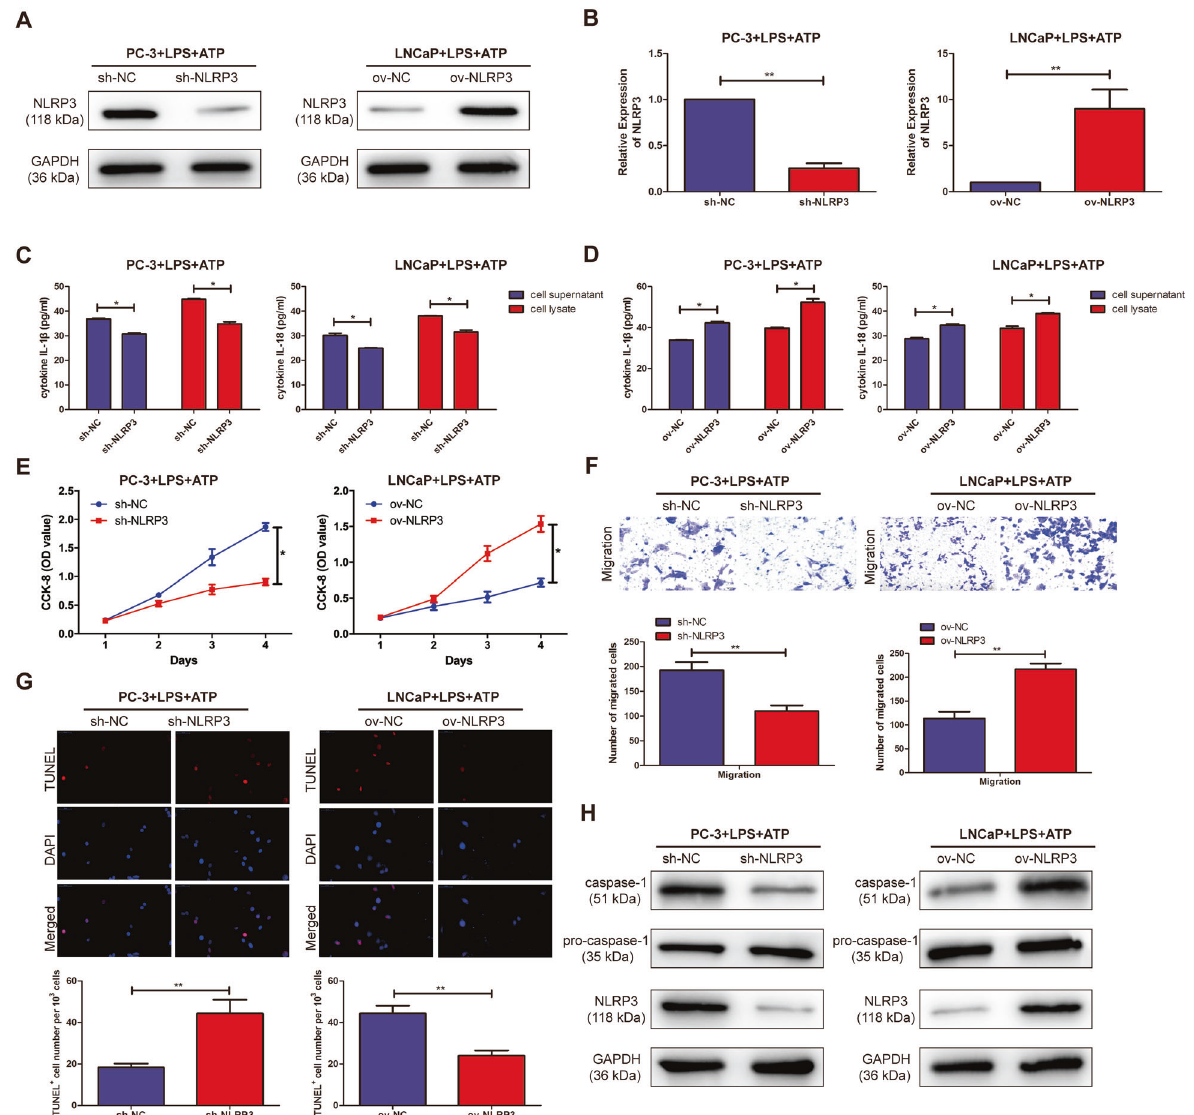
Fig. 3 Overexpression/knockdown of NLRP3 promoted/inhibited the malignant progression in PCa cell lines. A Western blotting analysis veri fi ed the transfection ef fi ciency of NLRP3 after overexpression/knockdown of NLRP3 in PC3 and LNCaP cell lines. B qRT-PCR analysis veri fi ed the transfection ef fi ciency of NLRP3 after overexpression/knockdown of NLRP3 in PC3 and LNCaP cell lines. C The expression of IL-1 β and IL-18 in the supernatant and lysate of PC3 and LNCaP cell lines were signi fi cantly decreased in sh-NLRP3, not in sh-NC group. D The expression of IL- 1 β and IL-18 in the supernatant and lysate of PC3 and LNCaP cell lines were signi fi cantly decreased in ov-NLRP3, not in ov-NC group. E CCK-8 assay detected the proliferation of PCa cells in the transfection of NLRP3 overexpression/knockdown vector. F Transwell assay was used to detect the migration ability after the transfection of NLRP3 overexpression/knockdown vectors in PC3 and LNCaP cells (magni fi cation: ×40). G TUNEL assay was used to detect apoptosis after the transfection of NLRP3 overexpression/knockdown vectors in PC3 and LNCaP cells (magni fi cation: ×40). H Western Blot was used to detect the expression level of NLRP3 and caspase-1 after the transfection of NLRP3 overexpression/knockdown vectors in PC3 and LNCaP cells. Data are average ± SD. * p < 0.05, ** p <